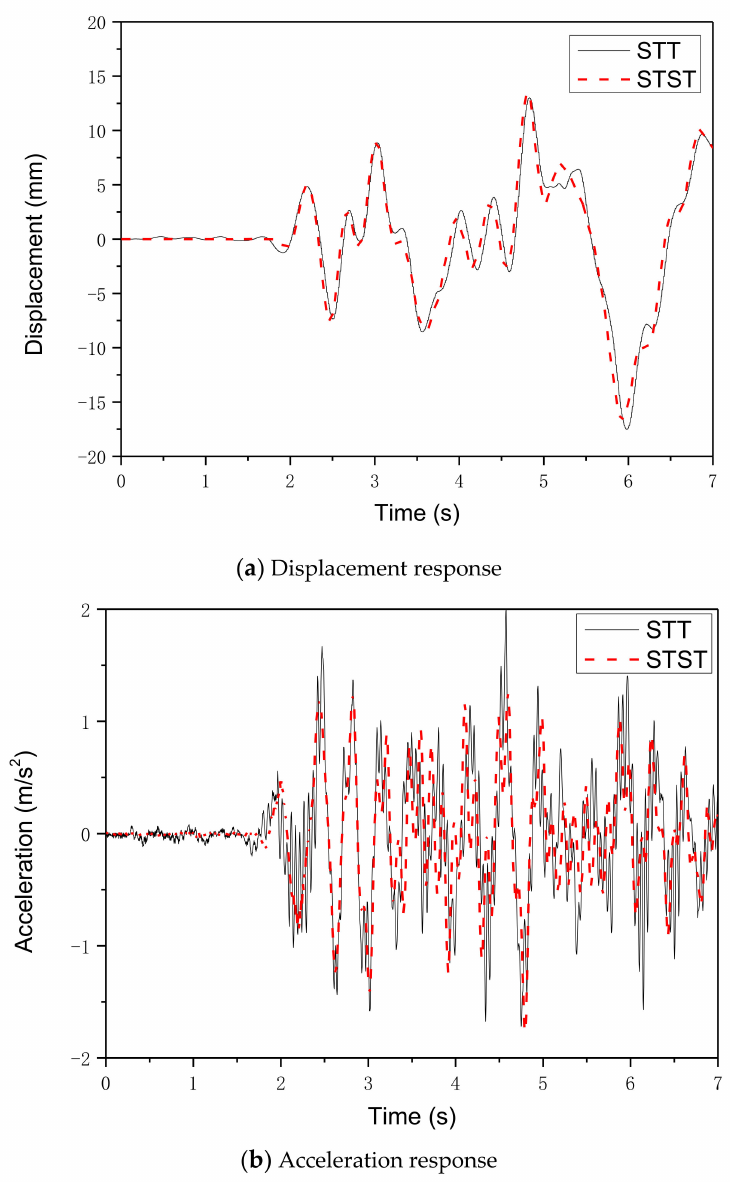
Figure 10. Experimental results with the El Centro